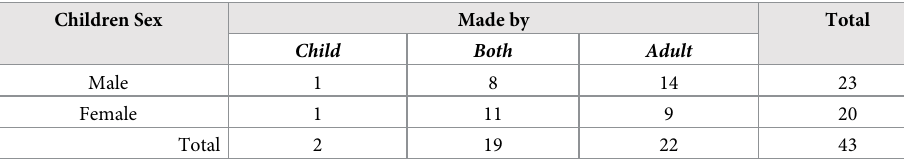
Table 7. Distribution of boys and girls participation with men. Children Sex Made by Total